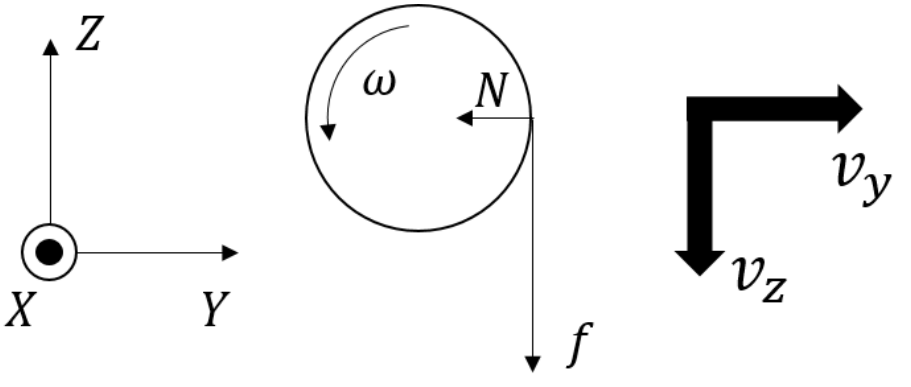
Figure 3. The forces on the SO in the first quarter